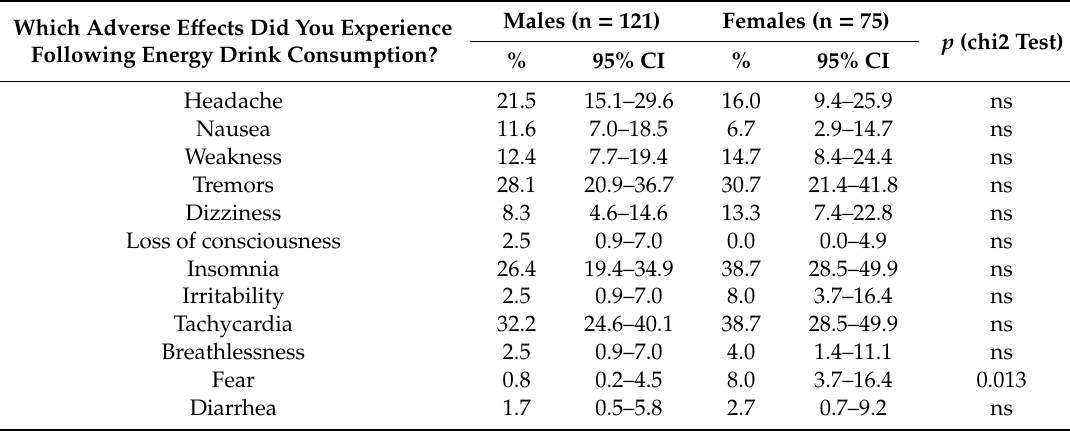
Table 3. Short-term adverse e ff ects of energy drink